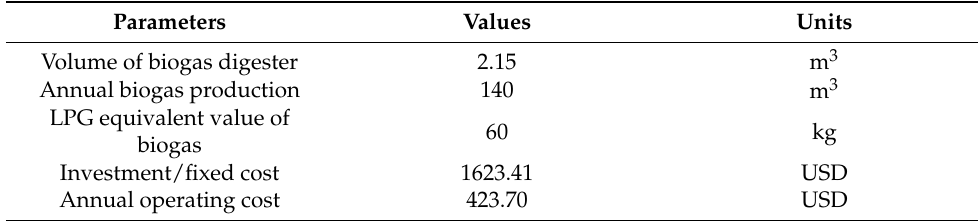
Table 7. Cost calculation of 2.15 m 3 biogas digester.